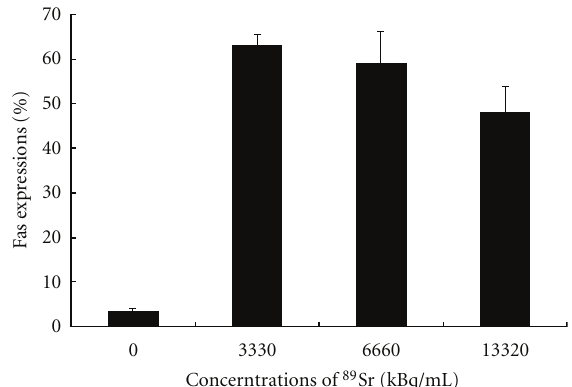
Figure 7: The Fas expression of MCF-7 cell due to being induced by 89 Sr of various